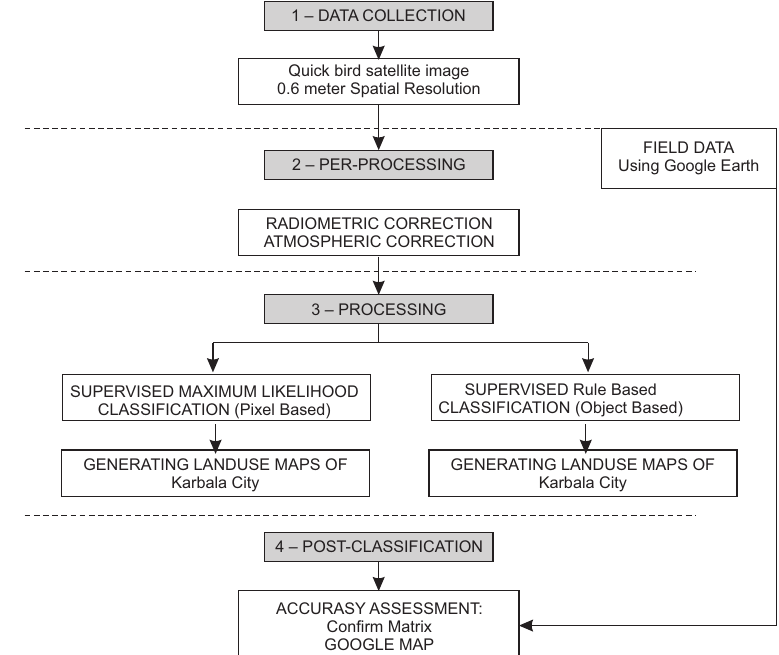
Figure 3. The schematic of research